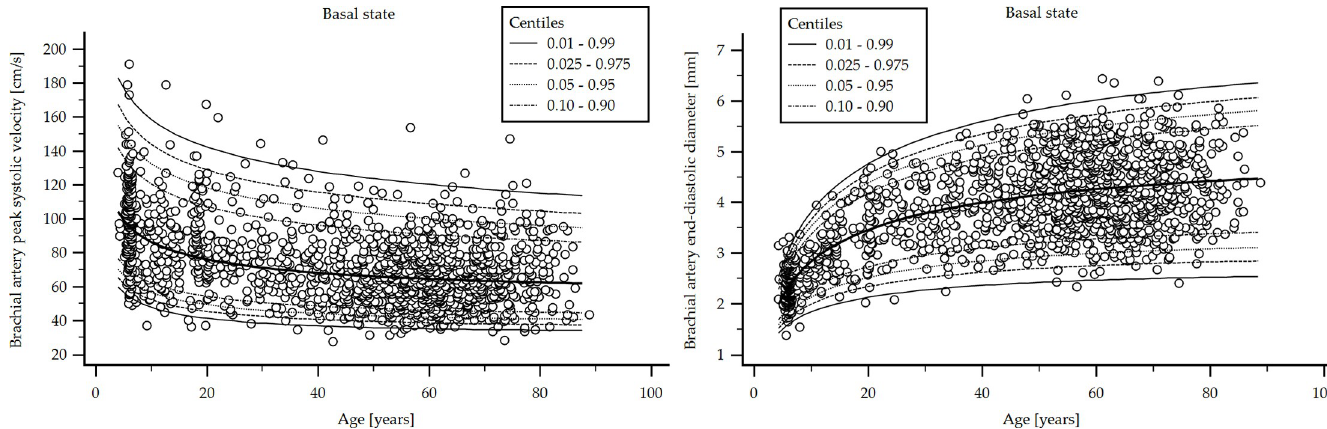
Fig 2. Age-related profiles: Brachial artery diameter and blood flow velocity. Age-related 1th, 2.5th, 5th, 10th, 50th, 90th, 95th, 97.5th and 99th percentiles for brachial artery (BA) end-diastolic diameter (DD) (Top) and peak systolic velocity (PSV) (Bottom).